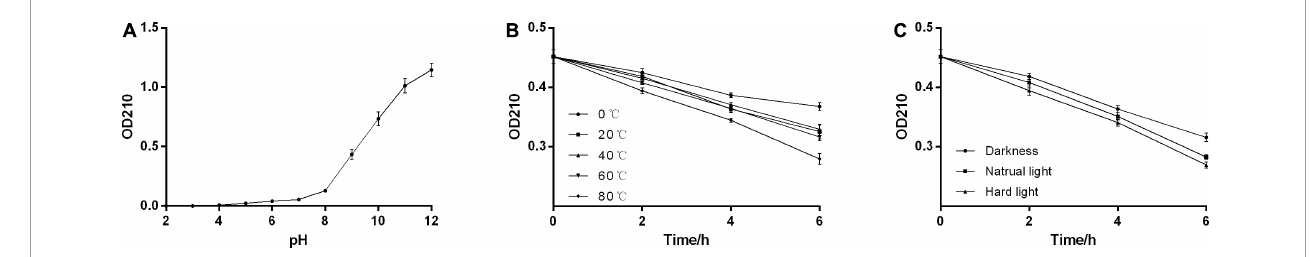
FIGURE4 Physicochemical properties of A. heimuer melanin (AHM). The solubility of AHM was determined by measuring the absorbance at 210 nm in response to various pH levels (A) . The stability of AHM was determined by measuring the absorbance at 210 nm in response to various temperatures over time (B) and light levels over time (C) .